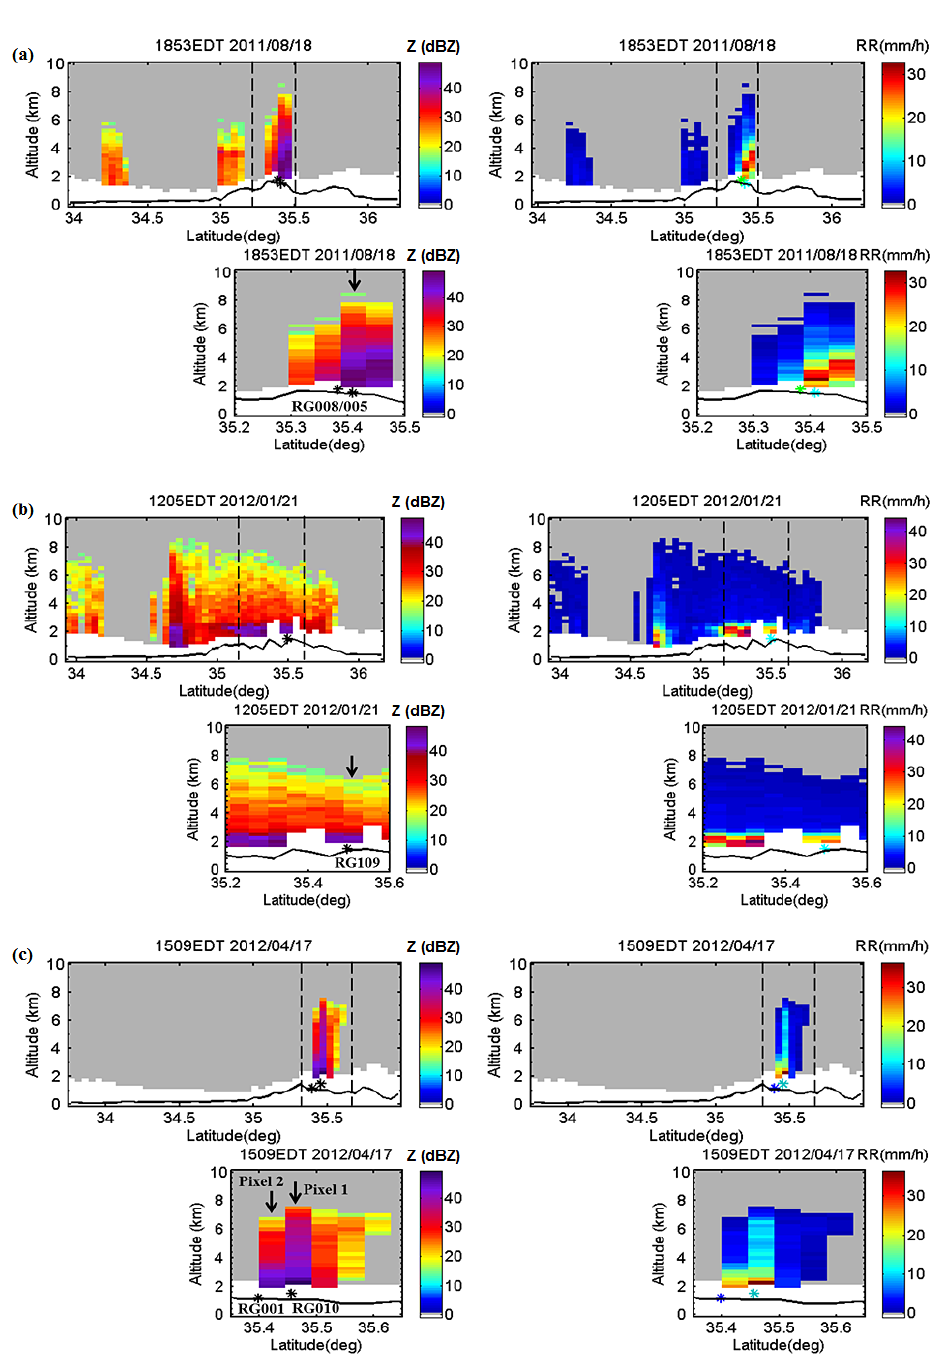
Figure 11. Cross section of reflectivity ( Z ) and rain rate estimates (RR) from TRMM 2A25 for three overestimation cases, respectively: (a) 18:53EDT on 18 August 2011; (b) 12:05EDT on 21 January 2012; and (c) 15:09EDT on 17 April 2012. The top row shows the overpass cross section. The bottom row shows the cross section between the two dashed vertical lines in the top row plots. Asterisks denote the position of the raingauges as marked, and the color in the right panel is consistent with the measured rain rate. The black arrow identifies the PR profile corresponding to the 2A25 used to make the error determination. Ground-clutter flags are shown in white. The black continuous line represents the